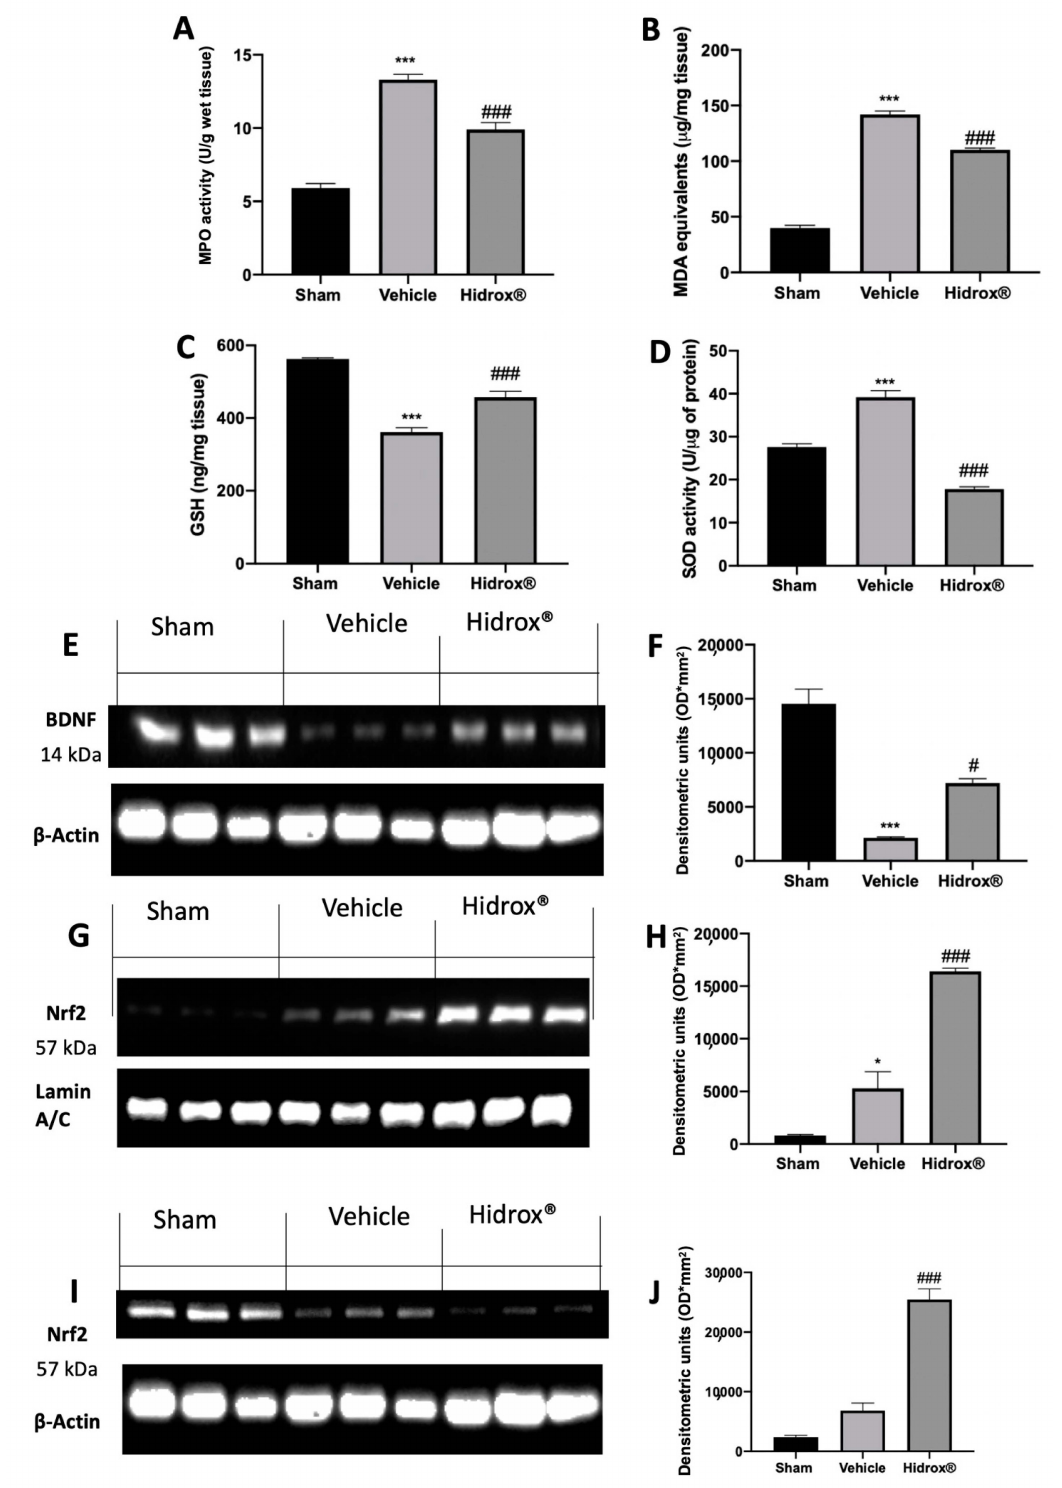
Figure 9. Hidrox ® administration reduced oxidative stress and improved BDNF and Nrf2 protein levels in hippocampus: MPO activity ( A ), MDA levels ( B ), GSH levels ( C ), SOD activity ( D ). Western blot analysis of BDNF from hippocampal tissue ( E ), densitometric analysis ( F ), Nrf2 nuclear expression from hippocampal tissue ( G ), densitometric analysis ( H ), Nrf2 cytosolic expression from hippocampal tissue ( I ), densitometric analysis ( J ). For the analyses, n = 5 animals from each group were employed. A p -value of less than 0.05 was considered significant. * p < 0.05 vs. sham, # p < 0.05 vs. vehicle, *** p < 0.001 vs. sham, ### p < 0.001 vs.